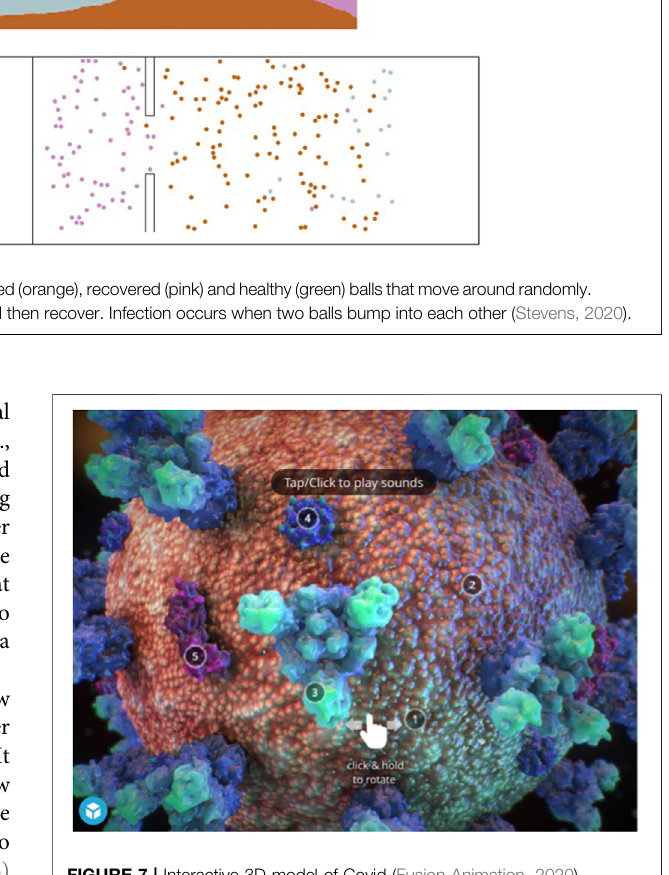
FIGURE 7 | Interactive 3D model of Covid (Fusion Animation,